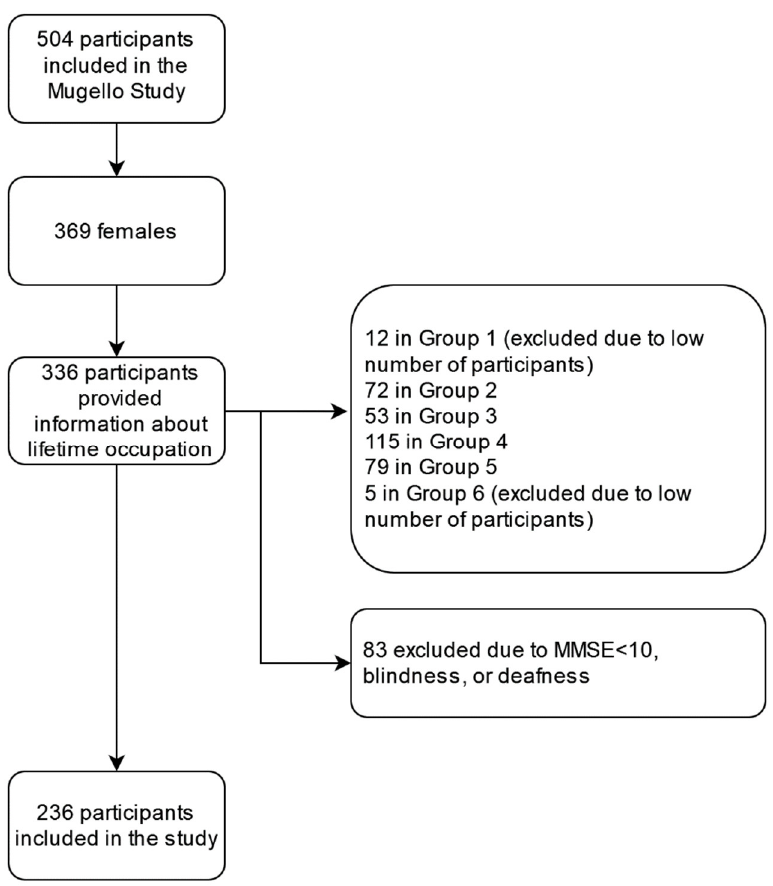
Figure 1. Flow diagram of the study participants.